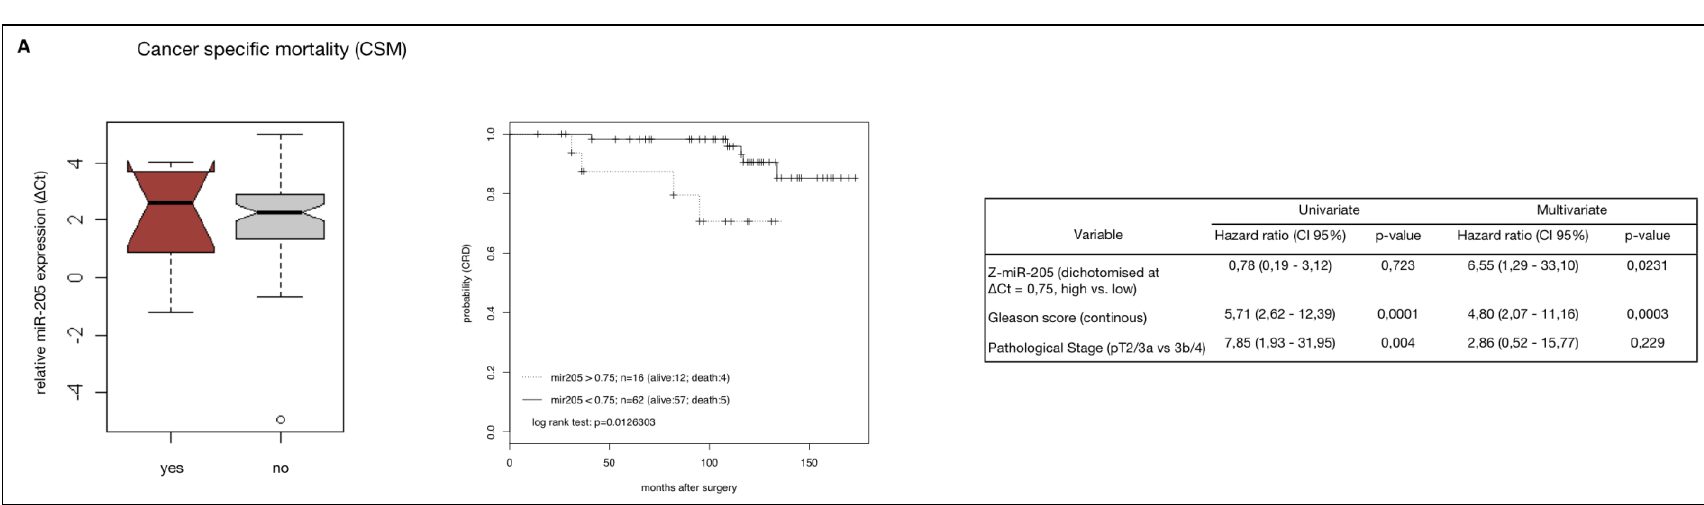
Figure 5. MiR-205 as a prognostic marker in a HRPCa validation cohort ( n = 78) for clinical endpoints ( A ) cancer-specific mortality (CSM); ( B ) clinical failure (CF) and ( C ) biochemical recurrence (BCR). Left plots : boxplots showing relative miR-205 expression (Δ C t sample) in patients with and without the indicated endpoints. Middle plots : Kaplan–Meier estimates in HRPCa patients with and without the respective endpoints. Patients were dichotomised by miR-205 expression according to optimal cut-off values for each endpoint calculated by ROC ( upper right plots ). p -values were calculated using log-rank test. Lower right tables: uni- and multivariate Cox-regression analysis regarding dichotomised miR-205 expression, Gleason score and combined pT score (pT2c/3a vs . pT3b/4) for the time to the respective end-points. p -values were calculated using Wald